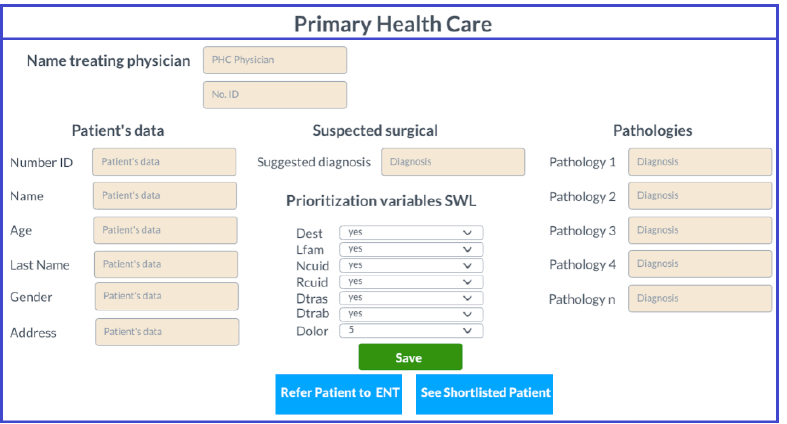
Figure 8. The patient consults in PHC. If the PHC physician suspects a surgical diagnosis for the surgical waiting list, he/she completes the variables and pathologies from the patient and refers him/her to ENT units, see Figure 9.